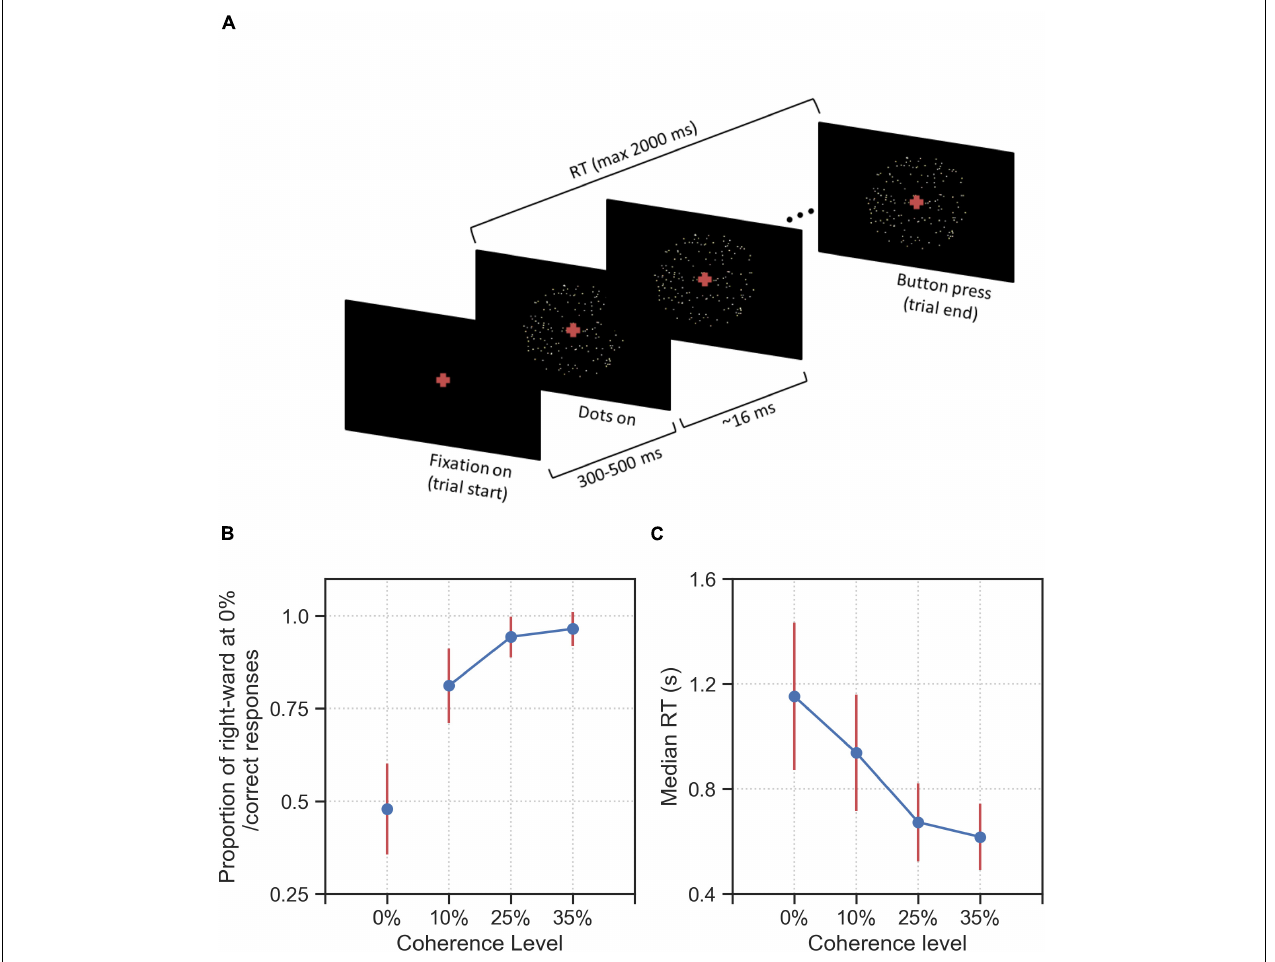
FIGURE 1 | Experimental design and behavioral results on group level. (A) a fixation cross was shown for a variable duration between 300 and 500 ms. After this fixation period, a cloud of ∼ 40 dots appeared within an aperture of 12 degrees on the center of the screen. In each trial, a proportion of all dots shown, as indicated by the coherence level, were moving toward the direction (right or left) indicated by the trial-wise target alternative. The remaining dots were displaced randomly within the aperture. Dot positions were updated every 16 ms. The trial ended when the participant makes a decision (button press) or a maximum of 2,000 ms has elapsed from the onset of the first frame of dots. The task was to decide into which of two directions the dots were moving (left or right). (B) Proportion correct (or proportion of rightward responses for 0% coherence stimuli) and (C) median RT averaged over all 44 participants for the four coherence levels (0%, 10%, 25%, and 35%). Error bars indicate the standard deviation across all participants, excluding the timed-out